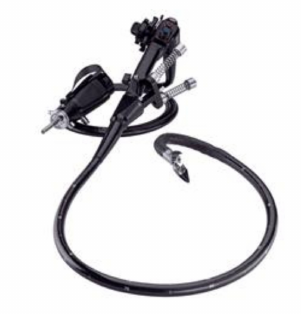
Figure 3. The ANUBIS project from Karl Storz for NOTES endoluminal and transluminal procedures